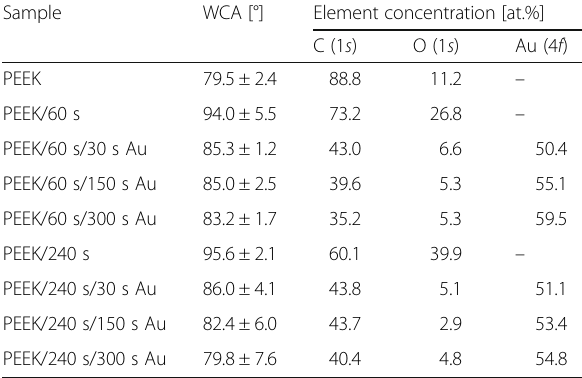
Table 2 Dependence of water contact angle (WCA, measured by goniometry) and concentrations of carbon, oxygen, and gold (by XPS) on PEEK modification: Ar plasma-treated (8.3 W, 60 and 240 s) and Au-sputtered (30, 150, and 300 s). The error of